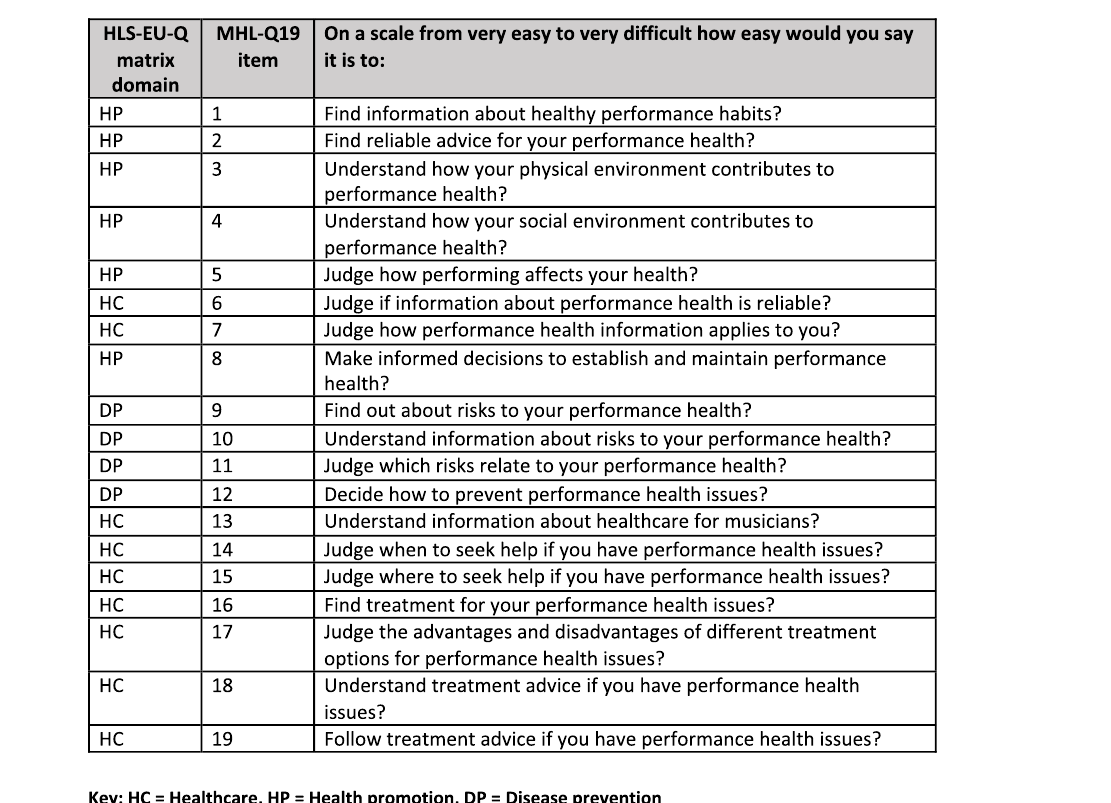
FIGURE 2 Questions from the Musicians’ Health Literacy Questionnaire, MHL-Q19, and their corresponding HLS-EU-Q matrix